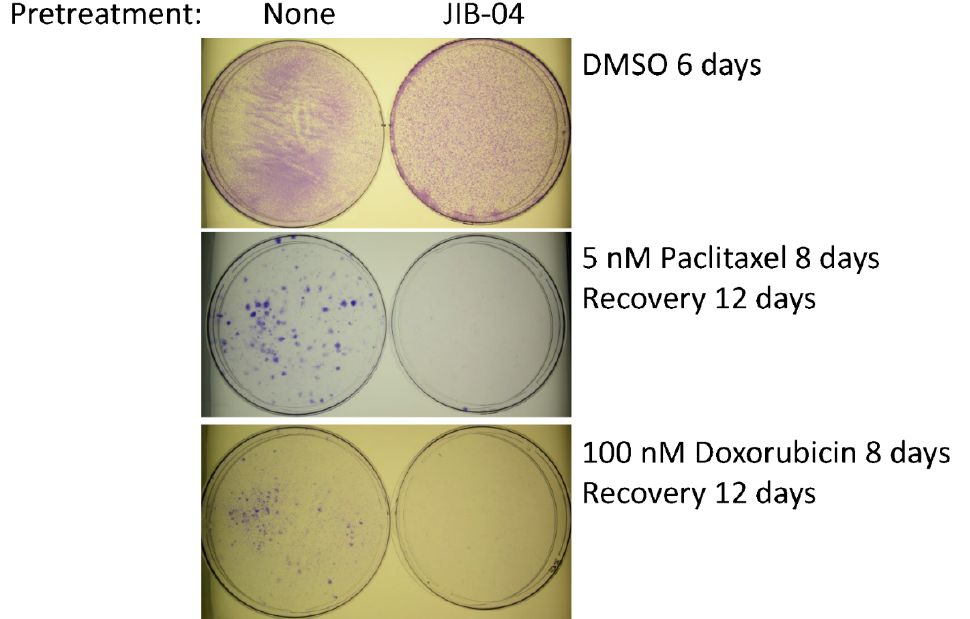
Figure 2. Treatment with JIB-04 sensitizes SUM149-MA cells to treatment with chemotherapeutic drugs. After a 10-day treatment with 125 nM JIB-04, we allowed surviving cells to recover in a drug-free medium for 7 days. Following this, we trypsinized the cells, plated them into fresh culture dishes, treated them in parallel with 5 nM paclitaxel ( middle panel) or 100 nM doxorubicin ( lower panel) for 8 days, and then let them recover and grow into colonies for 12 days before staining with crystal violet. Cells treated with DMSO in parallel that were stained 6 days later served as controls ( top panel). Representative images of cell cultures taken at 10× magnification are shown. These images show that pretreatment with JIB-04 significantly decreased the number of colonies.